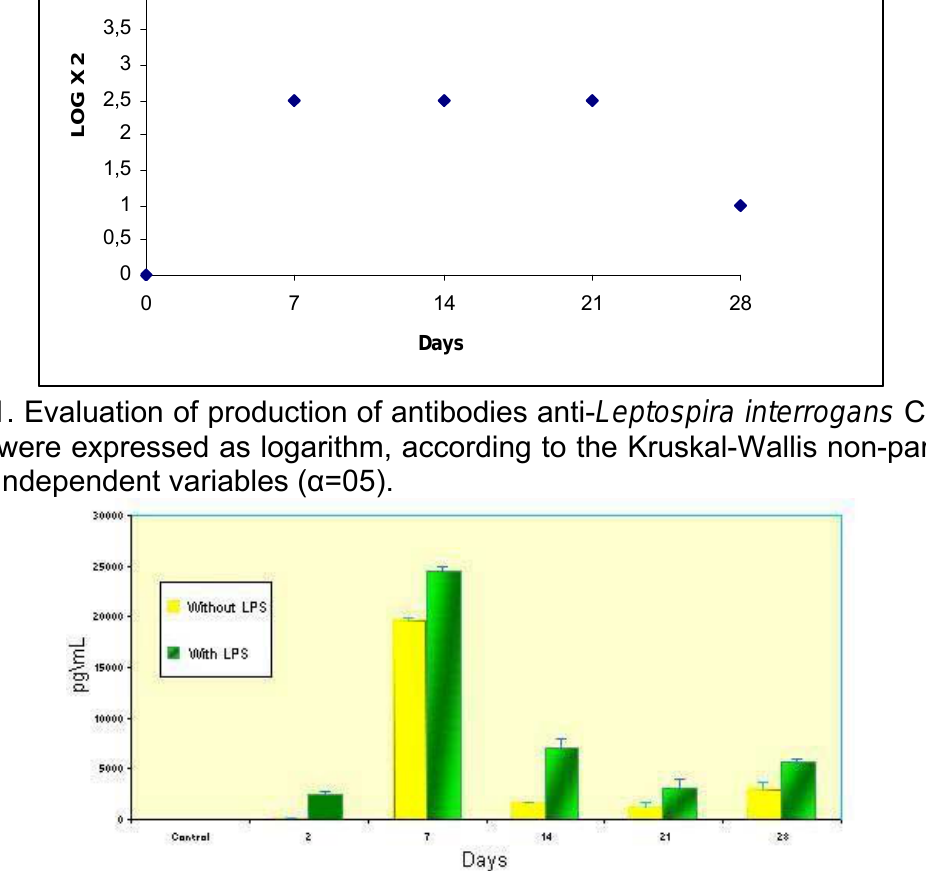
Figure 2. Levels of IL-6 produced by macrophages from BALB/c mice in the absence or presence of LPS in 24h-incubation culture. Values were expressed as